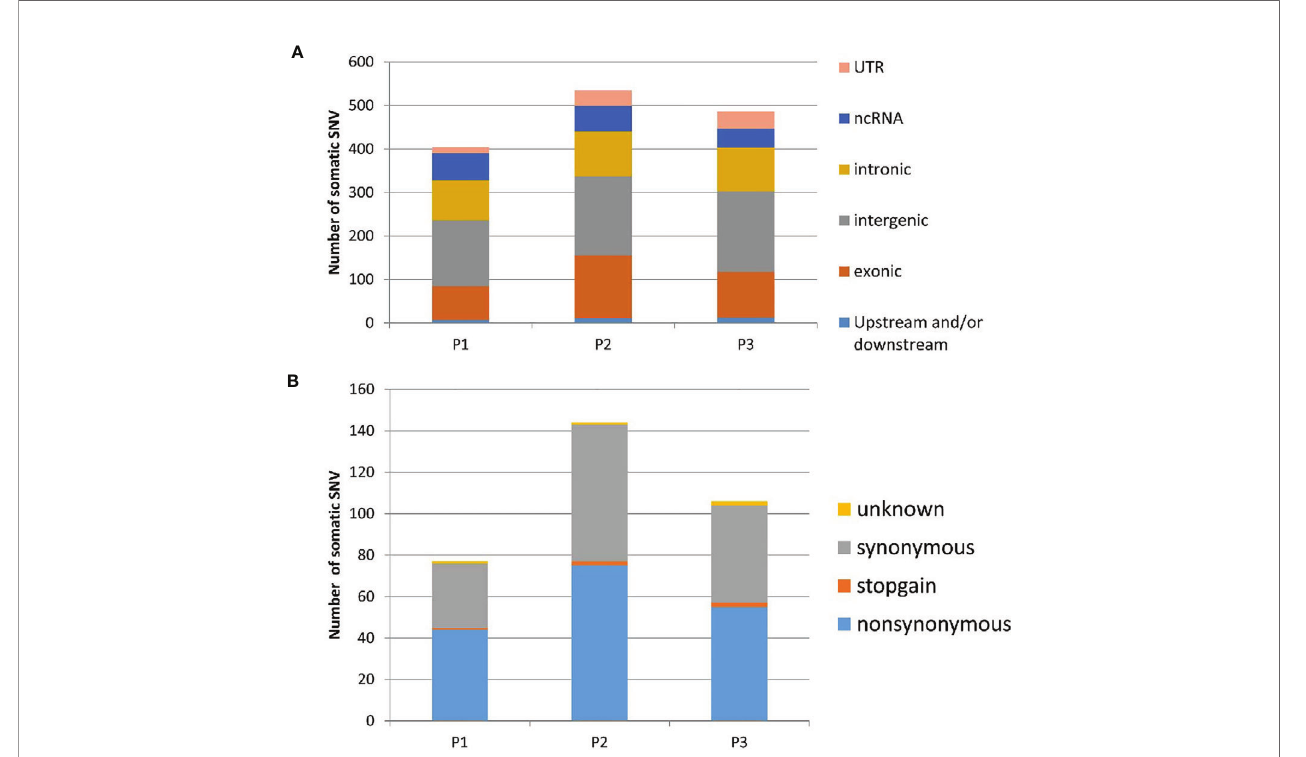
FIGURE 1 | Distribution of somatic SNVs in three uLMS patients identi fi ed by exomic sequence (A) . The component of exonic SNV annotated by ANNOVAR (B) . the component of exonic somatic SNV annotated by ANNOVAR. UTR, untranslated region; ncRNA, non-coding RNA; P1, Patients 1; P2, Patients 2; P3, Patients 3; SNV, single nucleotide